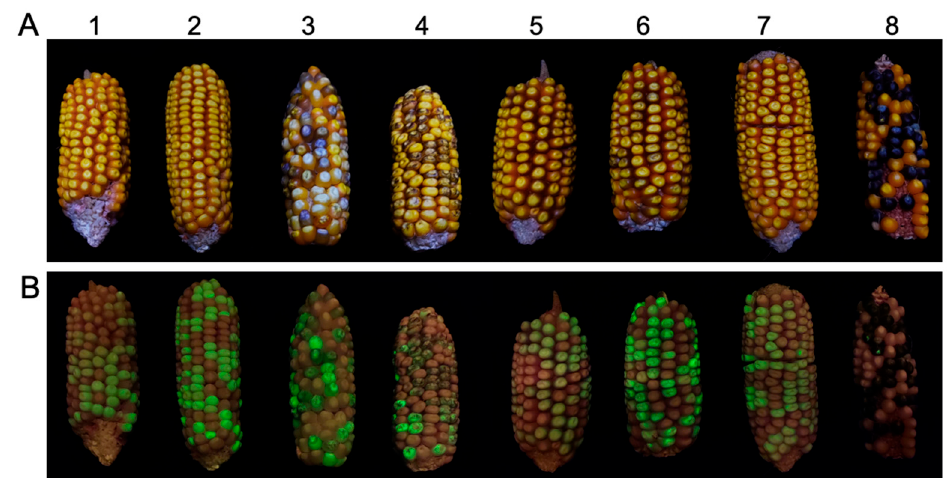
Figure 3. Kernel phenotype of test-cross ears. ( A ) Representative kernel pigmentation phenotypes of test-cross ears of the c1 tester line with primary transformants from various constructs. Anthocyanin pigmentation is varied in test-cross ears from primary transformants harboring individual c1-dHel-GFP constructs crossed to the c1 tester. ( B ) Representative kernel phenotype of GFP fluorescence segregation from the same test-cross ears as in ( A ) detecting under blue light illumination. 1, S3-Hel1613; 2, S3-Hel1158; 3, S3-HelA2; 4, S1-Hel1-4; 5, S2-Hel1-4; 6, S3-Hel1-4; 7, S4-Hel1-4; 8, positive C1 transgenic line.